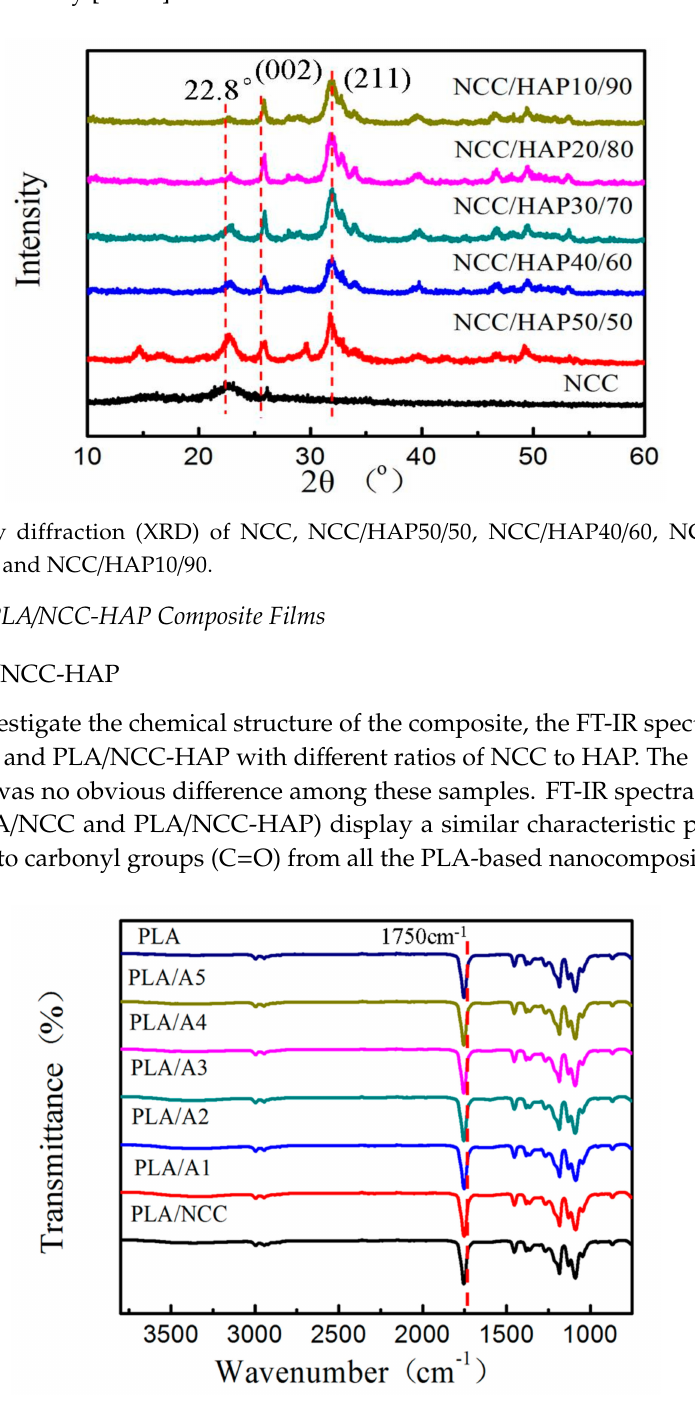
Figure 5. FTIR spectra of polylactic acid (PLA), PLA / NCC and PLA / NCC-HAP with di ff erent ratios of NCC to